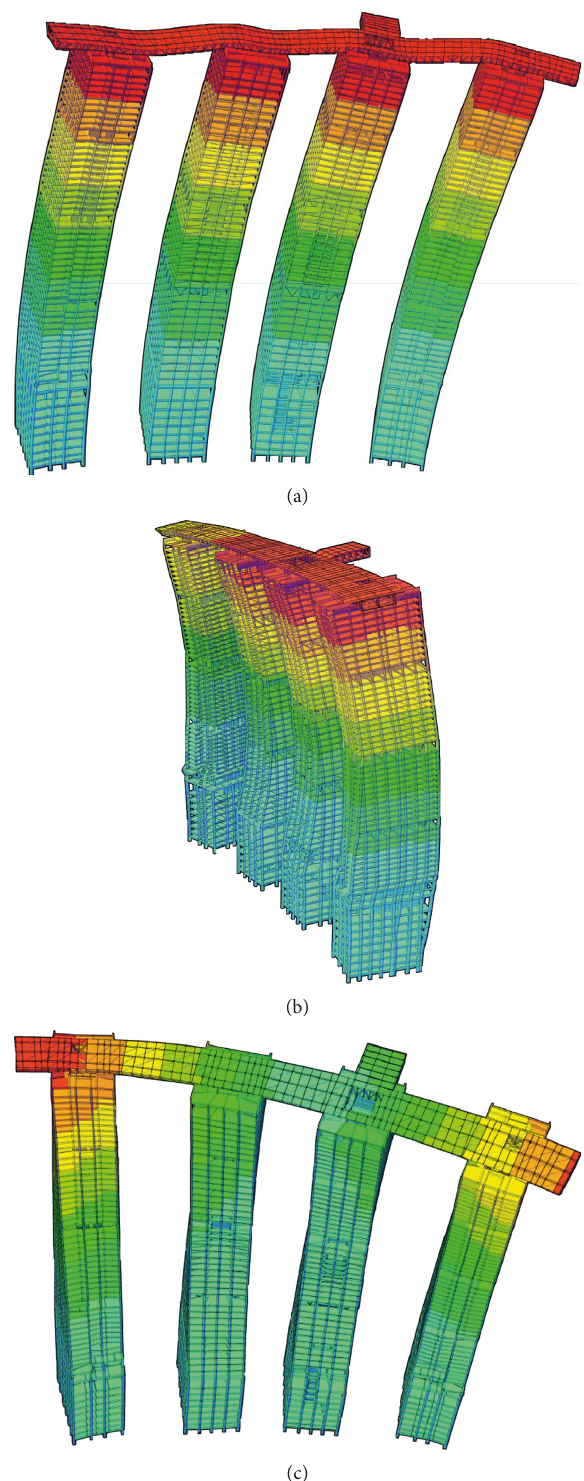
Figure 13: The first three vibration modes: (a) 1 st vibration mode, (b) 2 nd vibration mode, and (c) 3 rd vibration